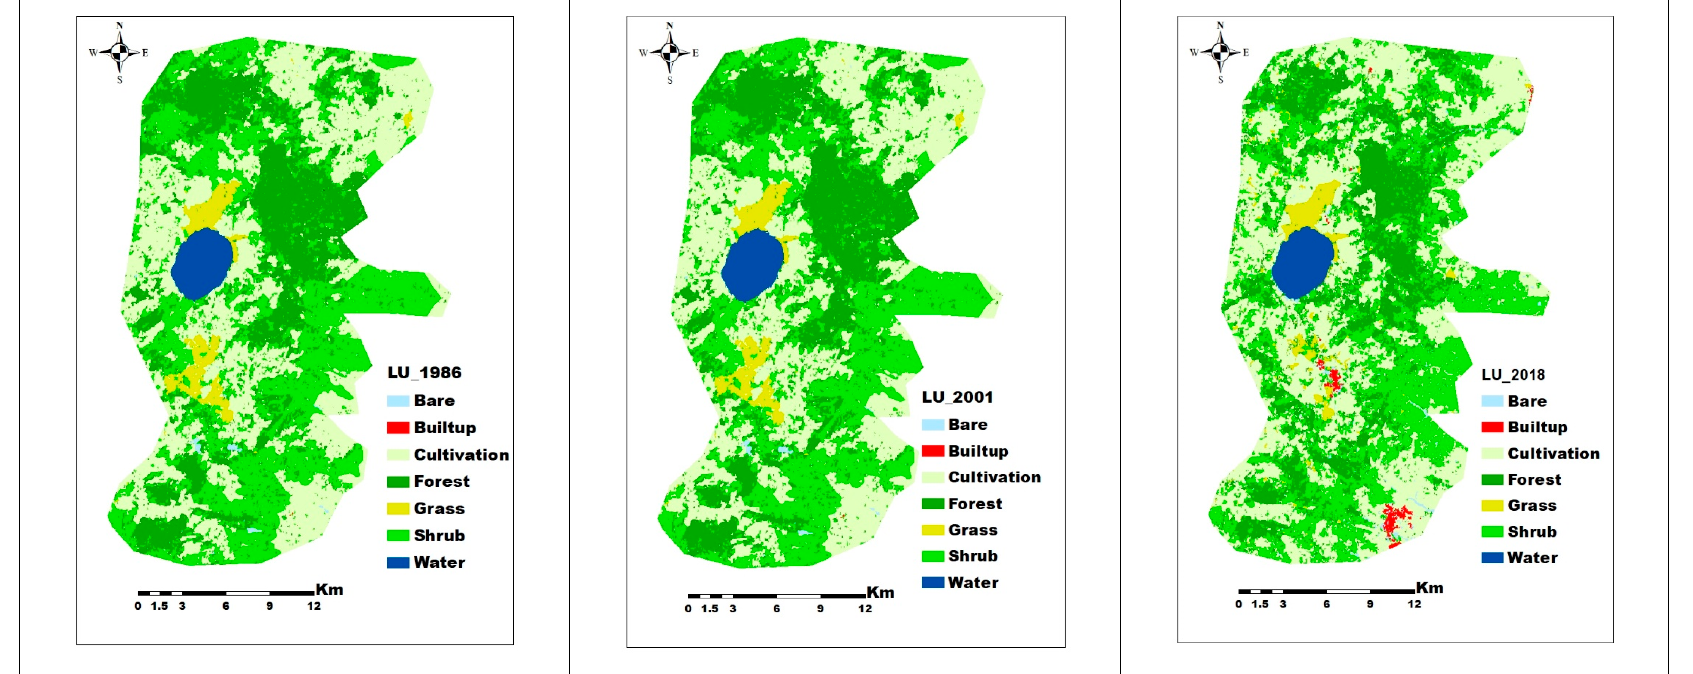
Figure 4. Land use and land cover dynamics in the year of 1986, 2001, and 2018 in Hugumburda Grat Kahisu State forest.